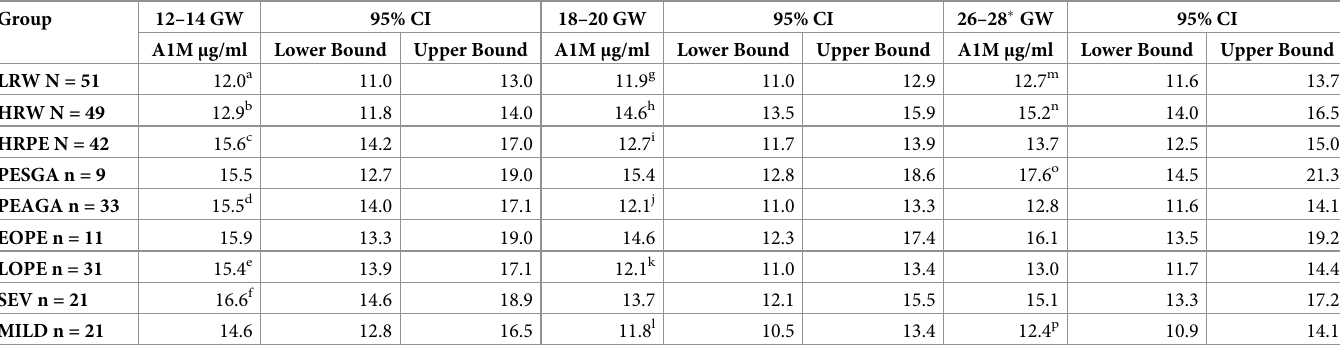
Table 6. Geometric mean plasma alpha-1-microglobulin concentration ( μ g/ml) by subgroups at three different sampling points during pregnancy. Group